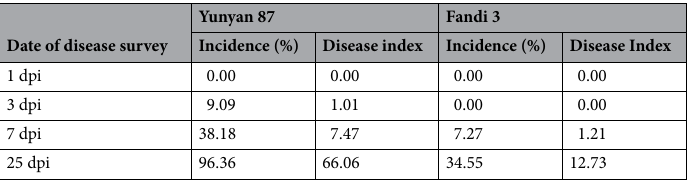
Table 1. Disease incidence and index of tobacco seedlings inoculated with R. solanacearum.